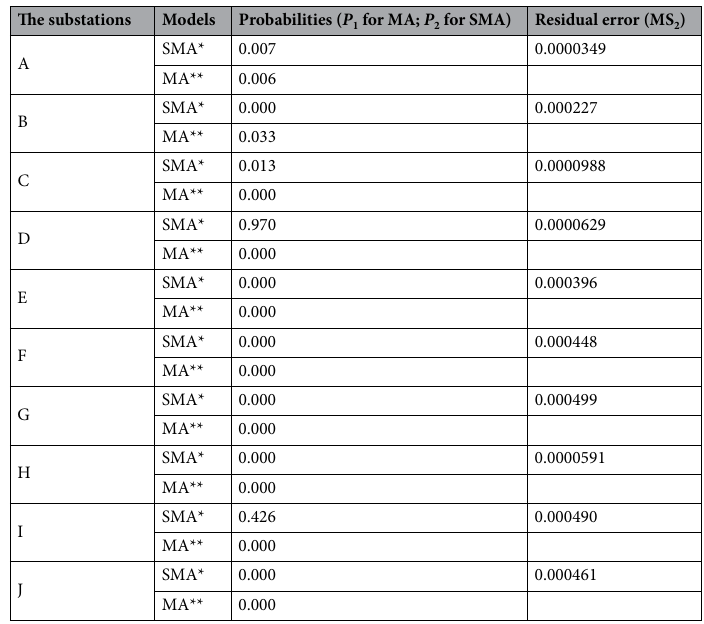
Table 1. The analysis of SARIMA ( 0,1,1 ) × ( 0,1,1 ) model for the open process in different substations. *SMA model implies the SARIMA ( 0,1,1 ) × ( 0,1,1 ) model. **MA model implies the ARIMA ( 0,1,1 ) model.